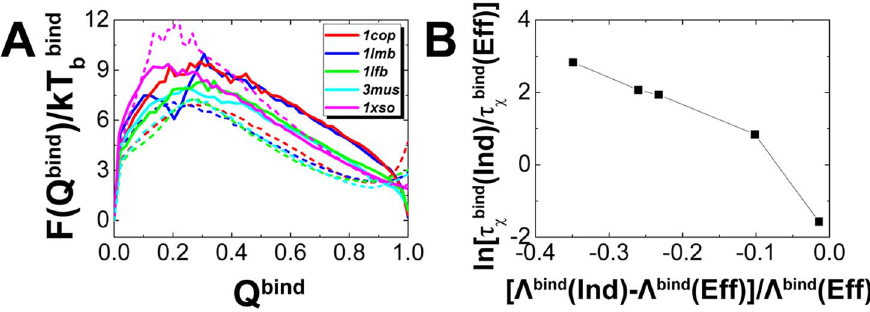
Figure 4. The differences of thermodynamics and kinetics between rigid and flexible binding. (A) The free energy landscapes of rigid and . (B) The differences of kinetics, represented by the ratio of binding time flexible binding are plotted at the corresponding binding temperature T bind b between rigid and flexible binding, are plotted along the differences of intrinsic specificity between rigid and flexible binding.